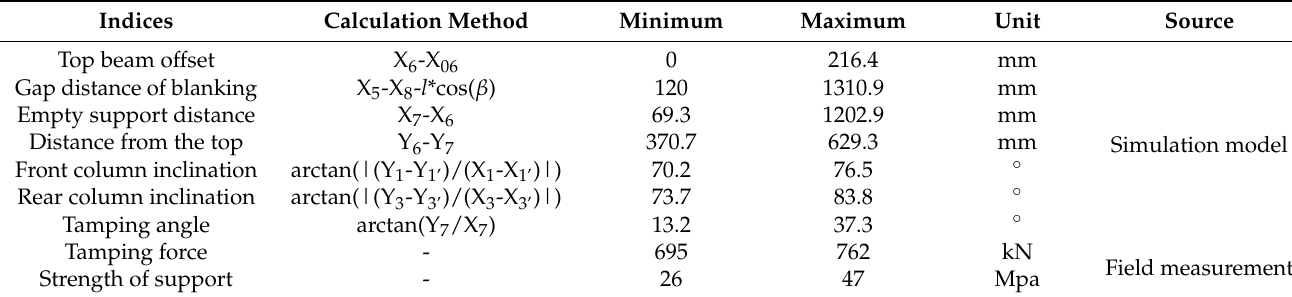
Table 2. The statistical parameters for the dataset.